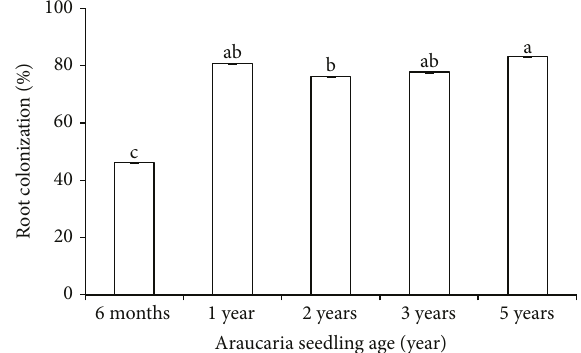
Figure 1: Root arbuscular mycorrhizal fungi (AMF) colonization araucaria seedlings with ages between 6 months and 5 years grown in a nursery in field in Curitiba, Brazil. Means followed by the same letter are not significantly different according to Tukey’s test ( 𝑝 ≤ 0.05 ). The error bars represent the standard error of the mean. 𝑛 = 5